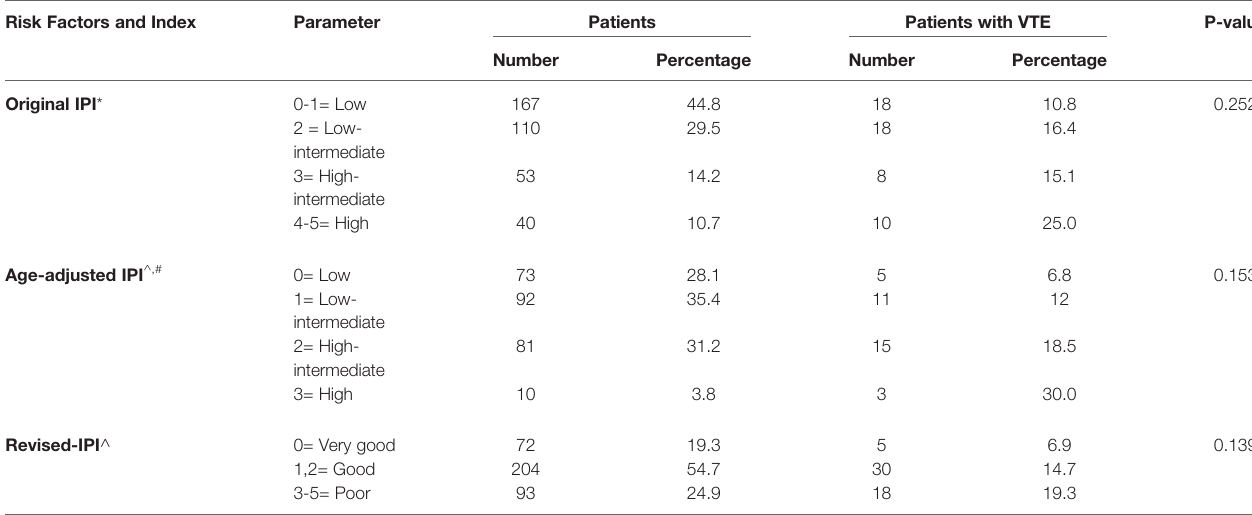
TABLE 4 | VTE rates according to IPI